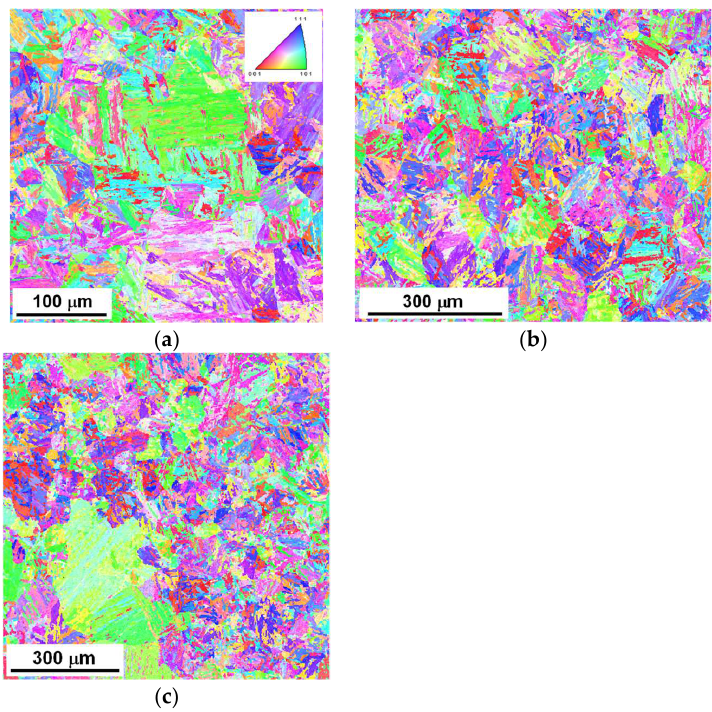
Figure 2. IPF (Inverse pole figure) ND (Normal Direction) maps obtained from the martensitic sample quenched from recrystallized austenite using different step sizes and scan areas. ( a ) Step size = 0.5 μm, 350 × 350 μm 2 ; ( b ) step size = 1 μm, 800 × 700 μm 2 ; and ( c ) step size = 1.5 μm, 900 × 900 μm 2 .